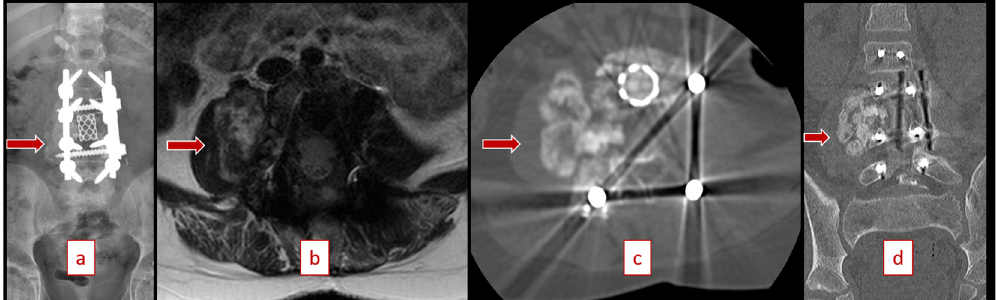
Figure 2. (a) PA of spine 9months post initial resection with recurrence (November 2016). (b) T2 Axial MRI demonstrating recurrent osteosarcoma extending into right psoas muscle (December 2016). (c, d) CT scan cuts demonstrating recurrent osteosarcoma with previous retained implants (December